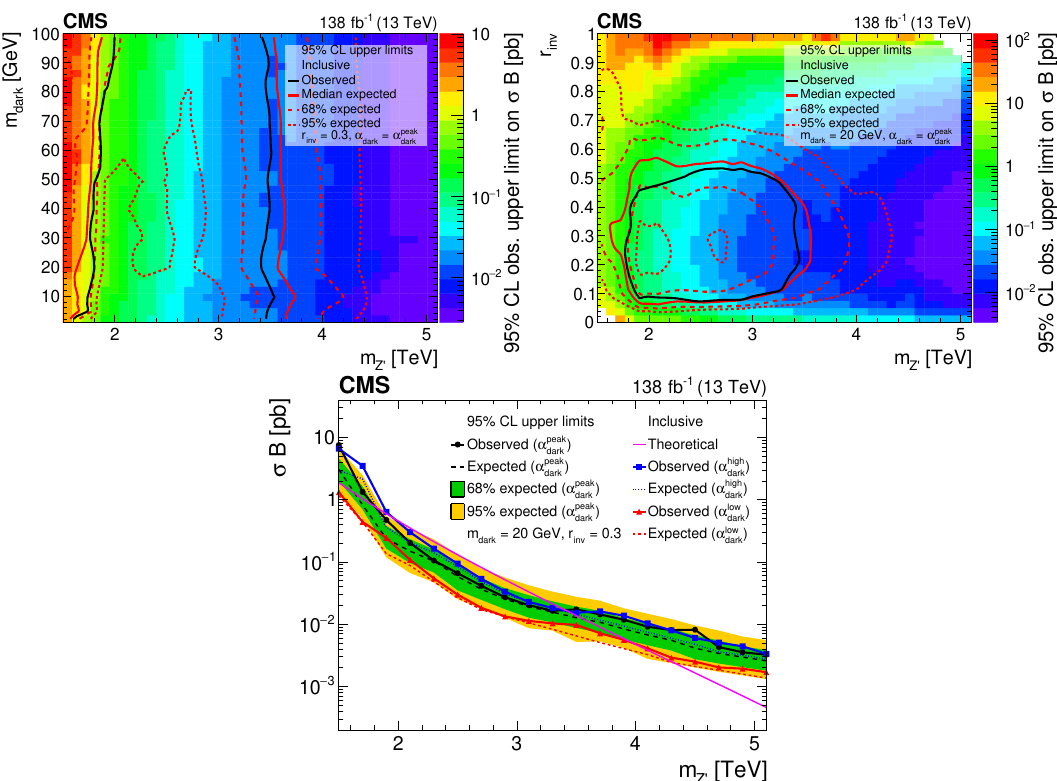
Figure 7 . The 95% CL upper limits on the product of the cross section and branching fraction from the inclusive search, for variations of pairs of the signal model parameters. In the upper plots, the filled region indicates the observed upper limit. The solid black curves indicate the observed exclusions for the nominal Z 0 cross section, while the solid red curves indicate the expected exclusions, and the dashed lines indicate the regions containing 68 and 95% of the distributions of expected exclusions. In the upper left plot, the regions between the respective pairs of lines or below the inner 95% dashed line are excluded. In the upper right plot, the regions inside the circles are excluded. The lower plot shows the α variation as multiple curves in one dimension, because there are only dark three parameter values considered. The black, blue, and red solid lines show the observed upper limits for each variation, while the dashed lines show the expected limits. The inner (green) and outer (yellow) bands indicate the regions containing 68 and 95%, respectively, of the distributions of expected limits. The purple solid line labeled “Theoretical” represents the nominal Z 0 cross